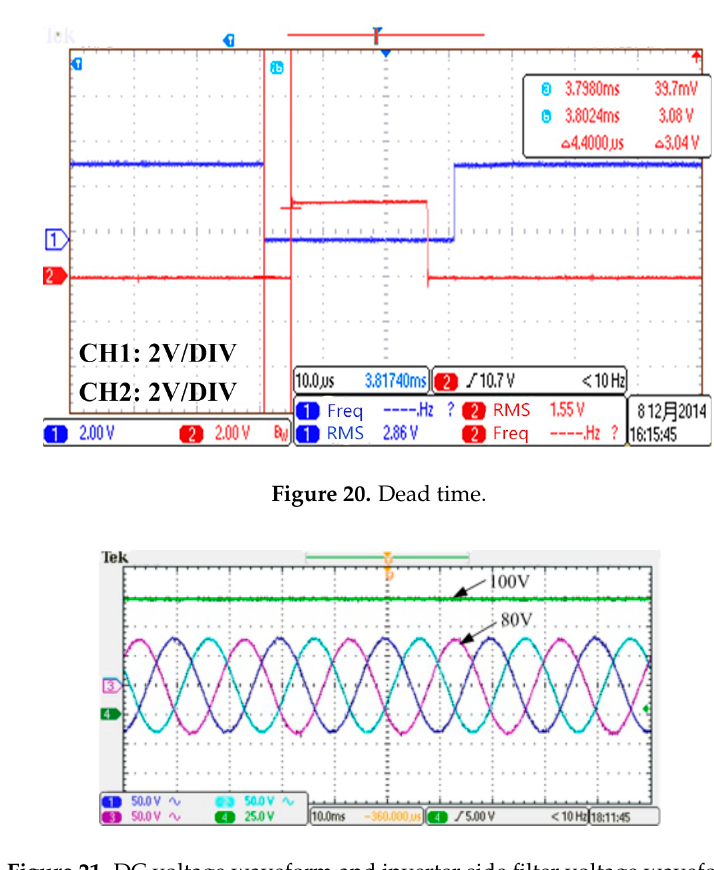
Figure 21. DC voltage waveform and inverter side filter voltage waveform.